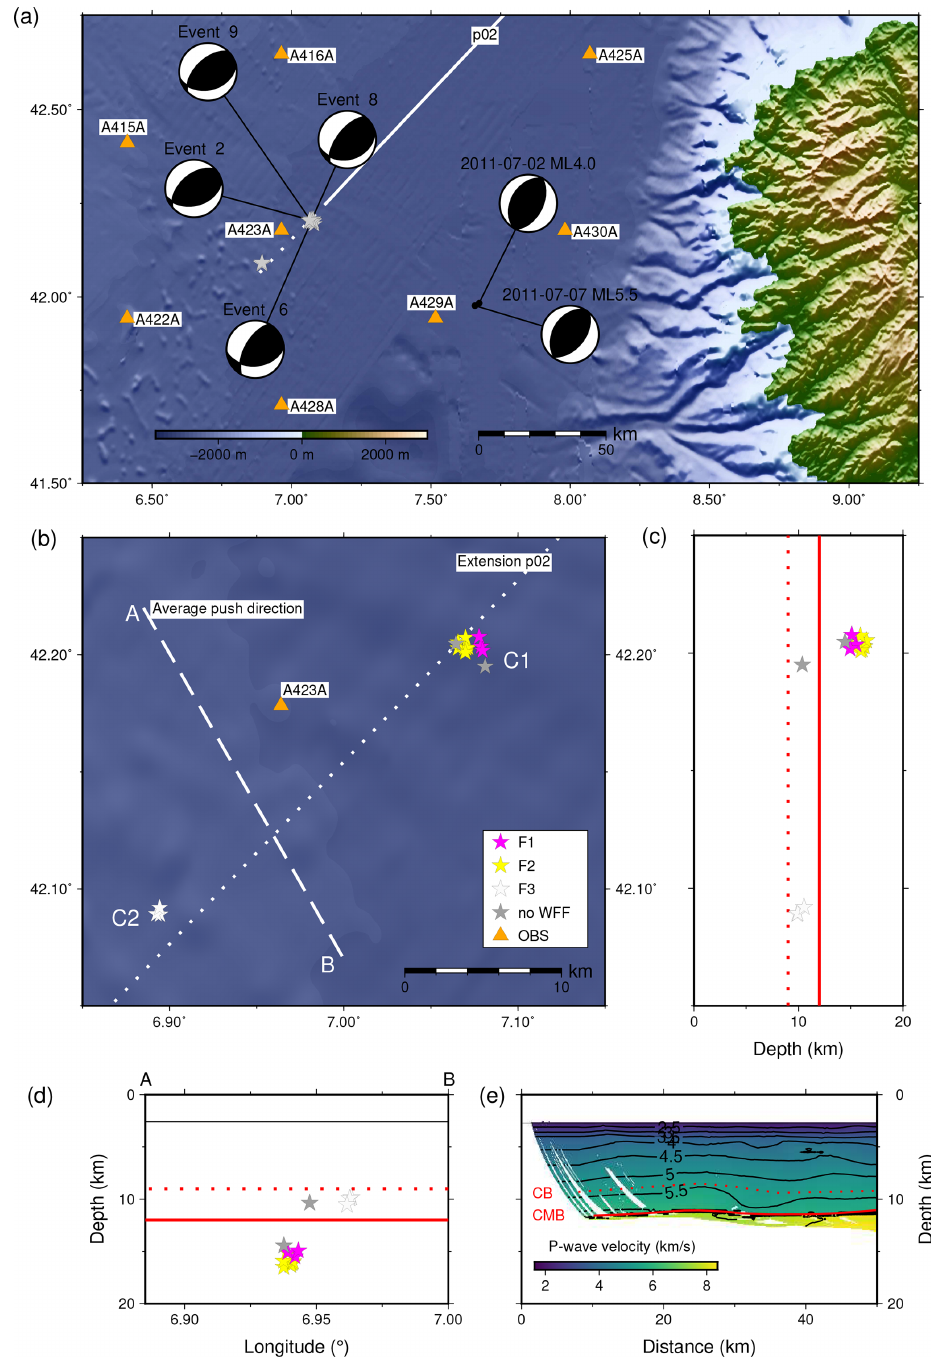
Figure 5. (a) Focal mechanisms of C1 cluster and two events in 2011 (Larroque et al., 2016). (b) Close-up of the map from panel (a) . The white dotted line indicates the prolongation of seismic refraction profile p02 (white line in panel a ) and the white dashed line represents the main horizontal direction of the pressure axis P as indicated by focal mechanisms. Events are displayed coloured according to their wave form family (WWF). (c) Depth distribution of the cluster events from north to south. (d) Events projected on the dashed line A–B shown in panel (b) . The thin black line indicates the seafloor, the dotted red line is the base of the sediment layers (CB) and the solid red line is the crust–mantle boundary (CMB). (e) SW end of the seismic velocity model computed from seismic refraction profile p02 (Dannowski et al., 2020). Topography from GMRT data (Ryan et al.,